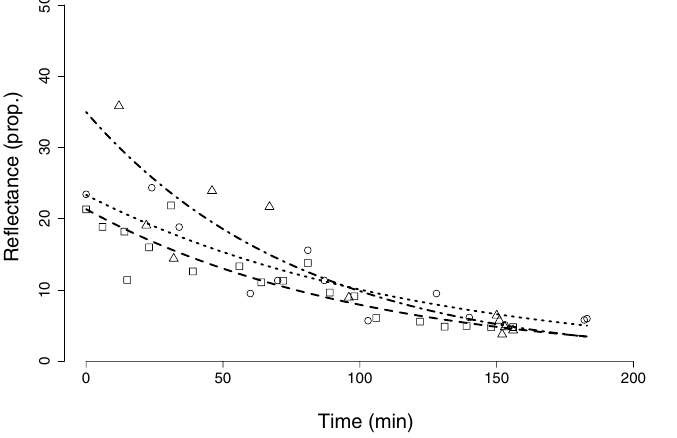
Figure 2. Reduction in narrow-sense SAR eyeshine with increased dark-adaptation in Scorpaena porcus . Narrow-sense SAR eyeshine total reflectance (pupil radiance normalized by white standard radiance) under coaxial illumination in the dark as function of time. At t = 0 the fish was light-adapted and the light was switched off resulting in total darkness. The small, coaxial source used to induce eyeshine was only switched on for a brief moment for each measurement. Radiance is integrated over 380–700 nm. Line styles and symbols indicate three different